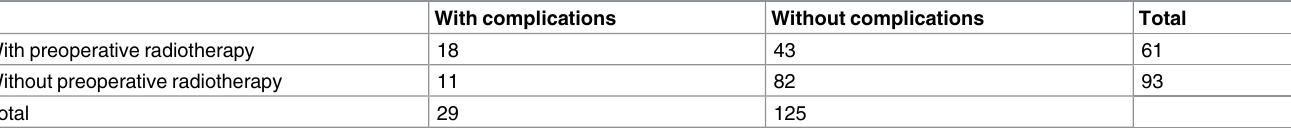
Table 7. Correlation of Preoperative Radiotherapy with Surgical